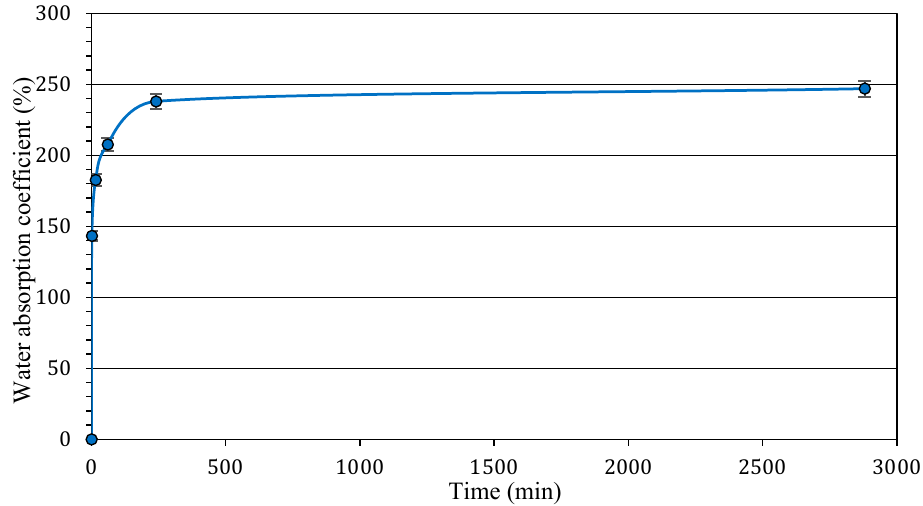
Figure 1. Water absorption kinetics of hemp shiv versus time.